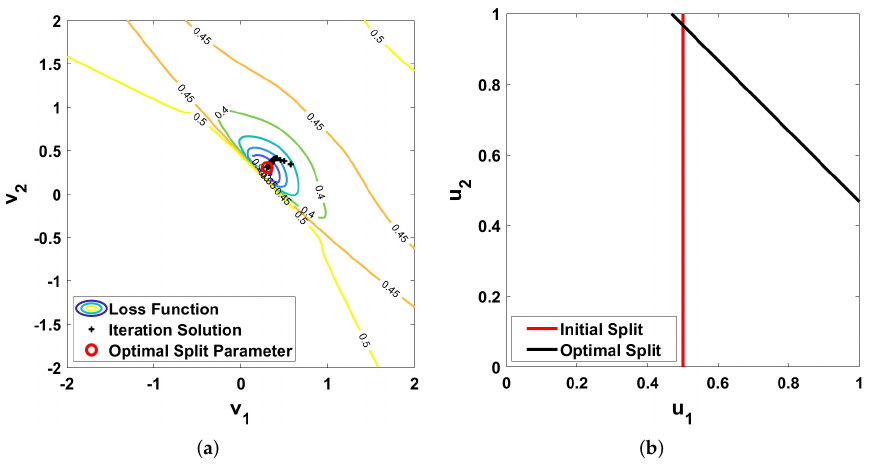
Figure 6. The loss function and model partition for EM algorithm after iteration 1. ( a ) Loss function. ( b ) Model